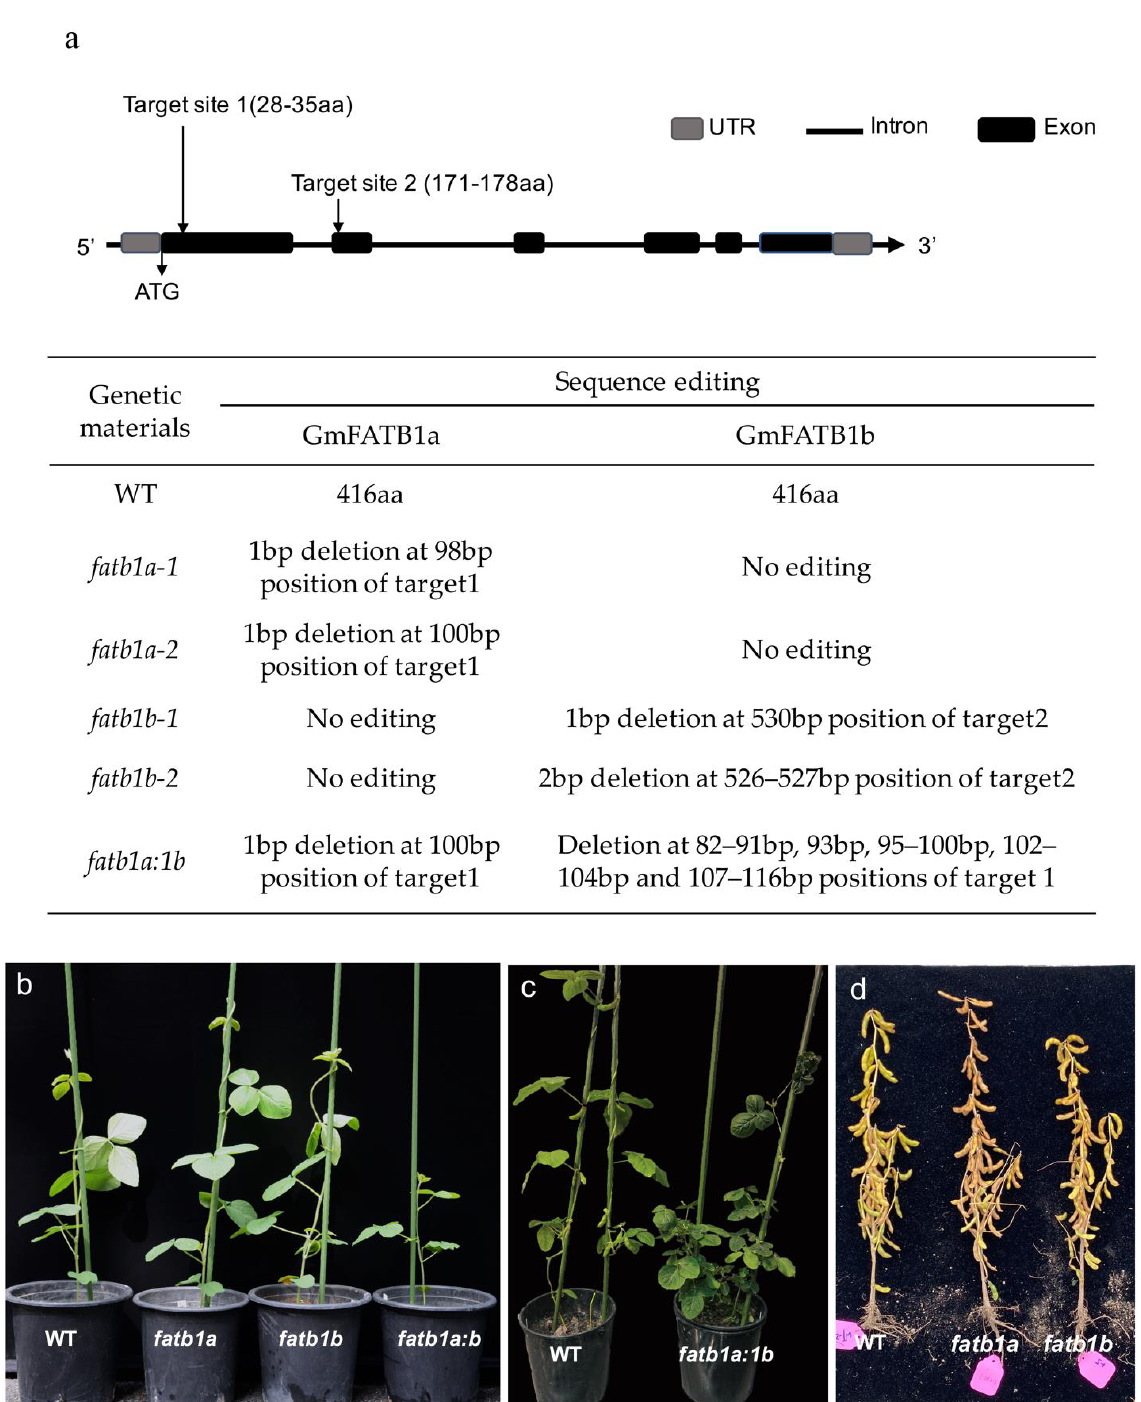
Figure 2. Identification of the mutant lines produced by the CRISPR-Cas9 system. ( a ) Gene structure and sequence targeted for alteration. The mutant sites are listed by form. ( b ) The growth characteristics of the mutant lines. The double mutant fatb1a:1b was overall shorter than the wild type, fatb1a and fatb1b , 21 days after germination, while no difference was observed with the single mutants. ( c ) The double mutant fatb1a:1b was overall shorter than the wild type. ( d ) The plant height of the wild type, fatb1a and fatb1b , were the same in the field experiment. WT: wild type.